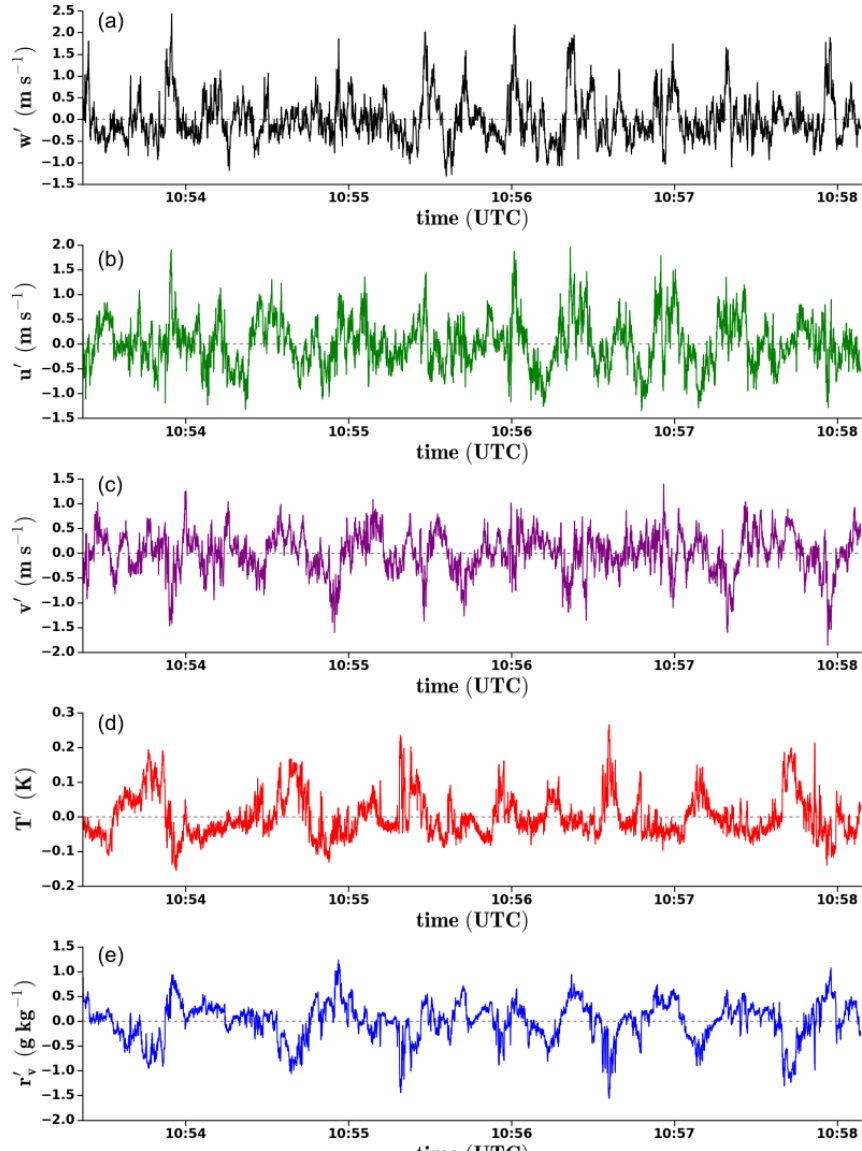
Figure 13. Time series of the filtered fluctuations of (a) vertical velocity, (b) wind velocity component longitudinal to the wind, (c) wind velocity component transverse to the wind, (d) potential temperature and (e) water vapor mixing ratio during a leg flown at z ∼ 275m on 13 February 2020